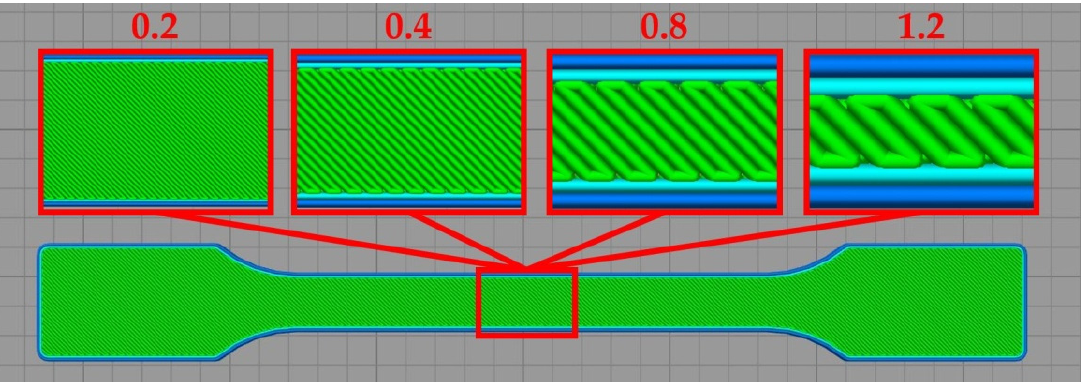
Figure 4. The arrangement of PLA paths in printed samples depending on the dimensions of the nozzle diameter used.